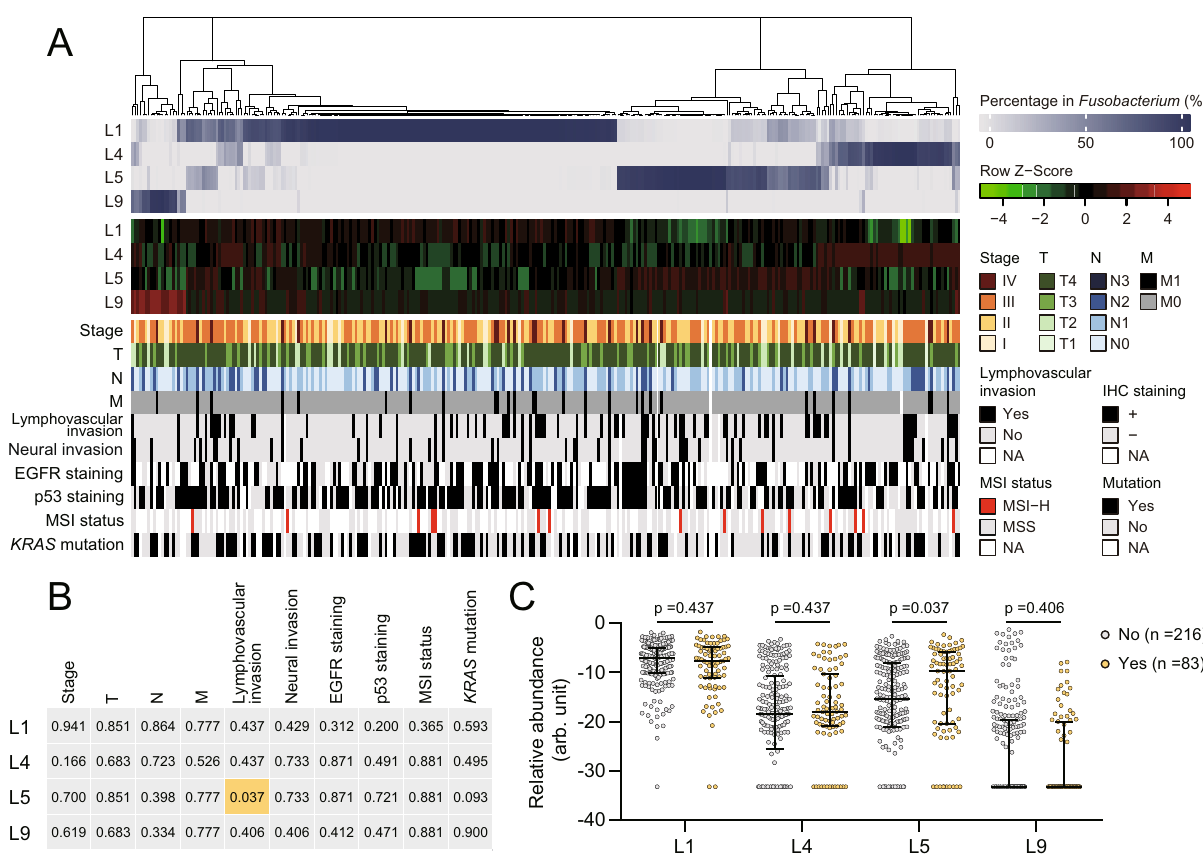
Fig. 5 Lineage 5 was enriched in tumour samples associated with lymphovascular invasion. A A heatmap showing the percentages in Fusobacterium communities and estimated relative abundance among bacteria in tumours and corresponding pathological characteristics were included for analysis. B Associations between lineage abundance and pathological characteristics. For each pathological characteristic, patients were grouped by the corresponding categories listed in ( A ), and lineage abundance was compared. The p values are summarised with orange and grey shades denoting signi fi cant and insigni fi cant results. See ( C ) and Fig. S10 for details of comparison and statistical analyses. C L5 abundance showed an association with lymphovascular invasion. Mann-Whitney test (two-sided) followed by the Benjamini-Hochberg correction. Adjusted p values are shown. Individual data points are shown along with the medians and interquartile ranges. arb. unit, arbitrary unit. See Supplementary Data 3 and 4 for detailed